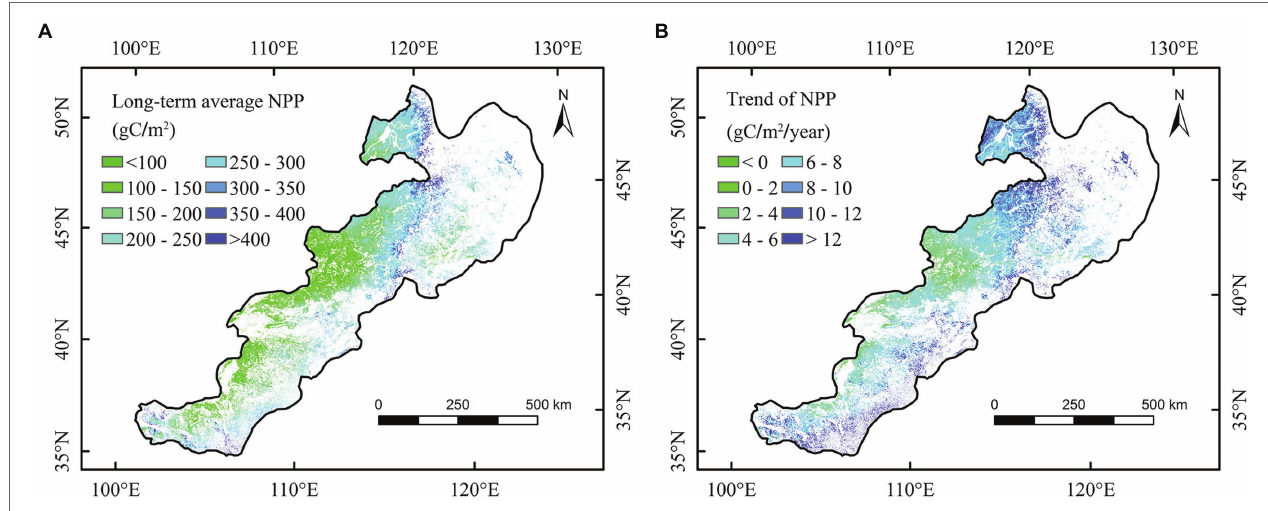
FIGURE 2 | Long-term average (A) and temporal trends (B) in annual net primary productivity (NPP) of China’s temperate grasslands during